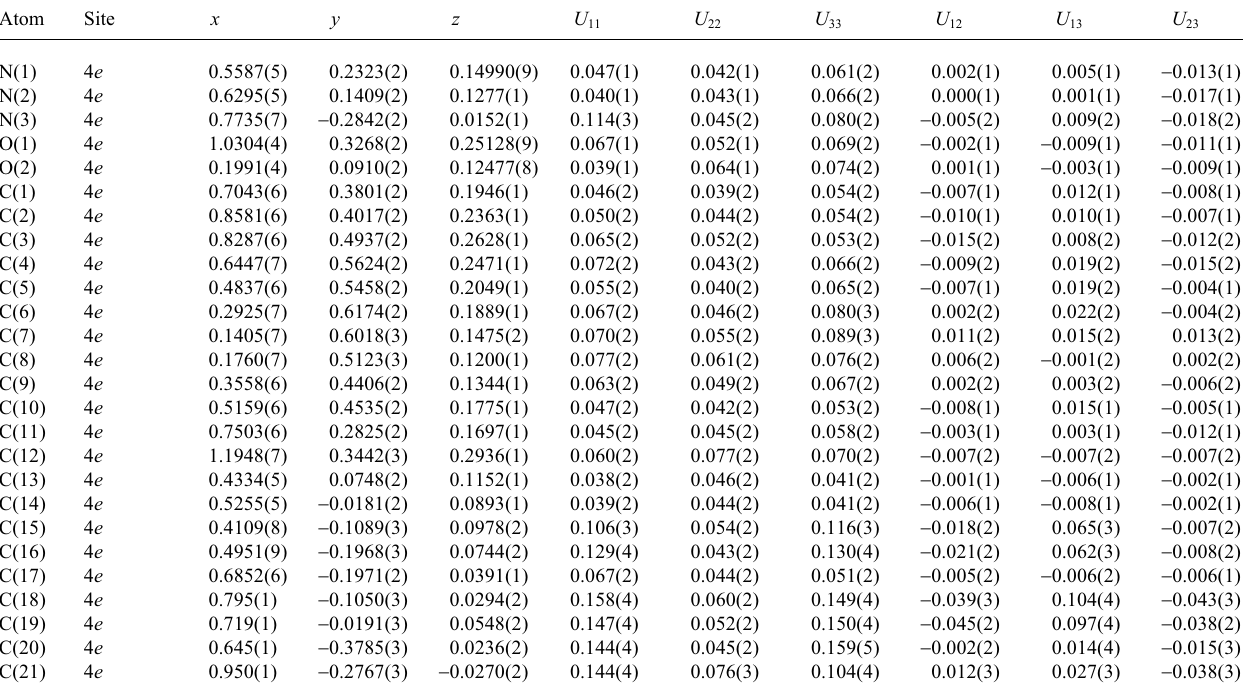
Table 3. Atomic coordinates and displacement parameters (in Å 2 )